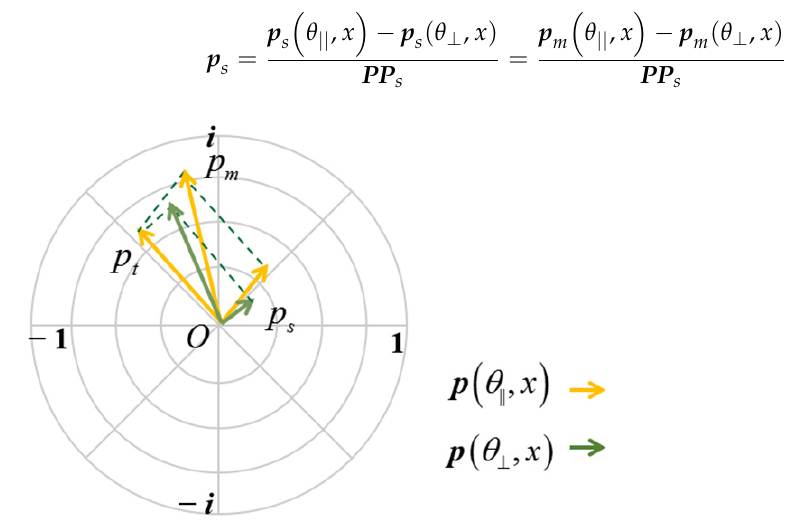
Figure 6. Polarization phasor representation in a scattering scene.